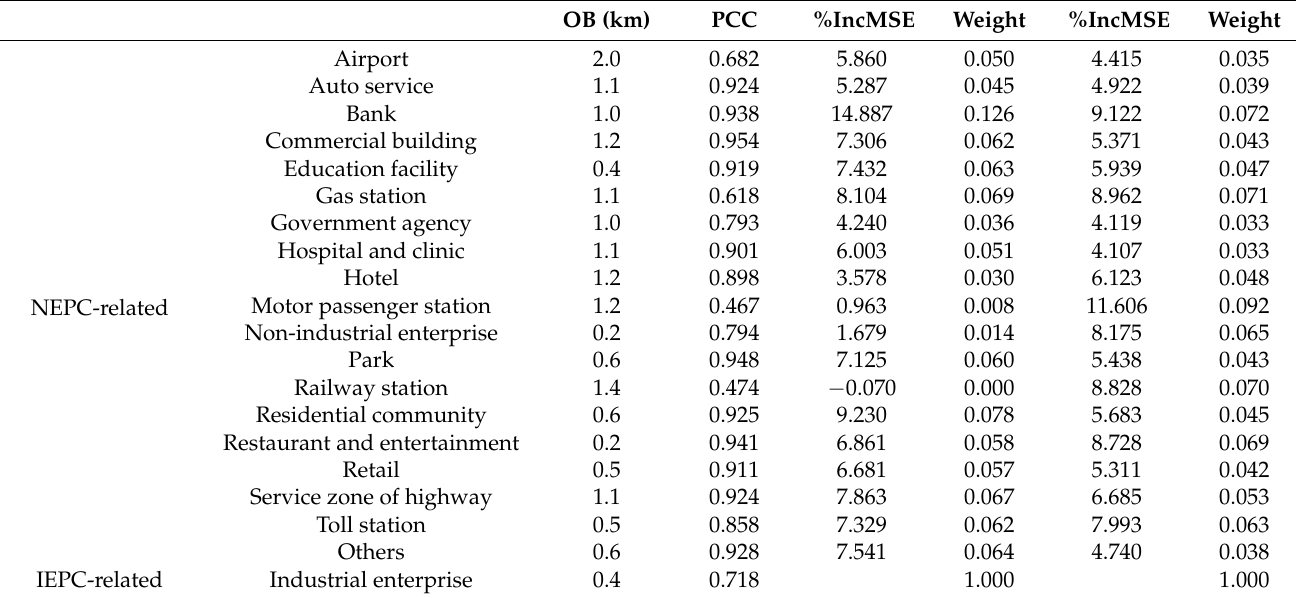
Table 1. List of the optimal bandwidth (OB), Pearson correlation coefficients (PCC), percent increased mean square error (%IncMSE), and the weight for each POIs